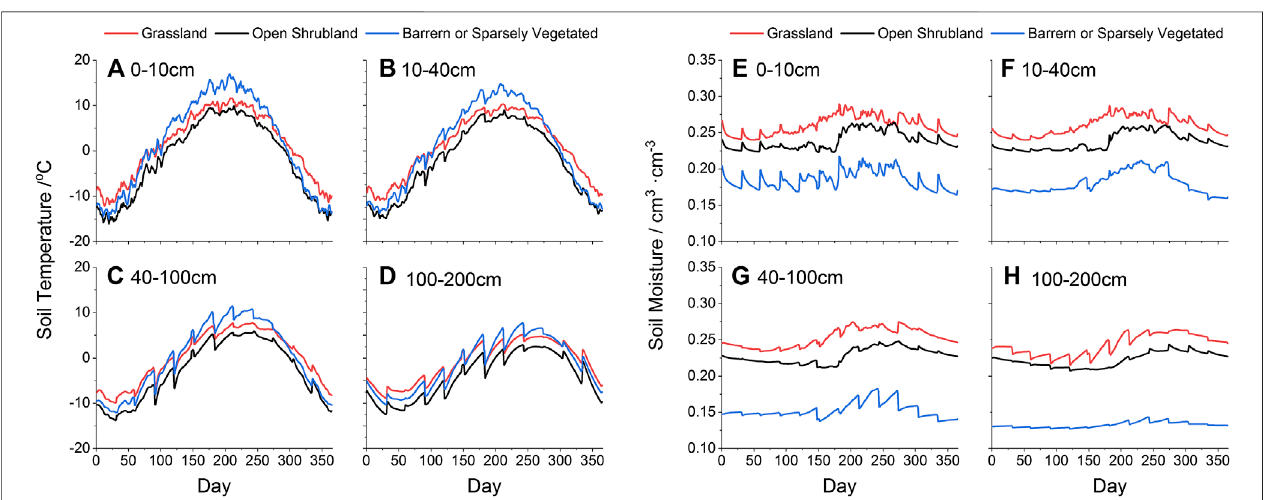
FIGURE 7 | The daily averaged variation of soil temperature ( ° C) and soil moisture (cm 3 · cm − 3 ) over Grassland (red line), Open shrubland (black line), and Barren or sparsely vegetated (blue line) in the Qinghai-Tibet Plateau.